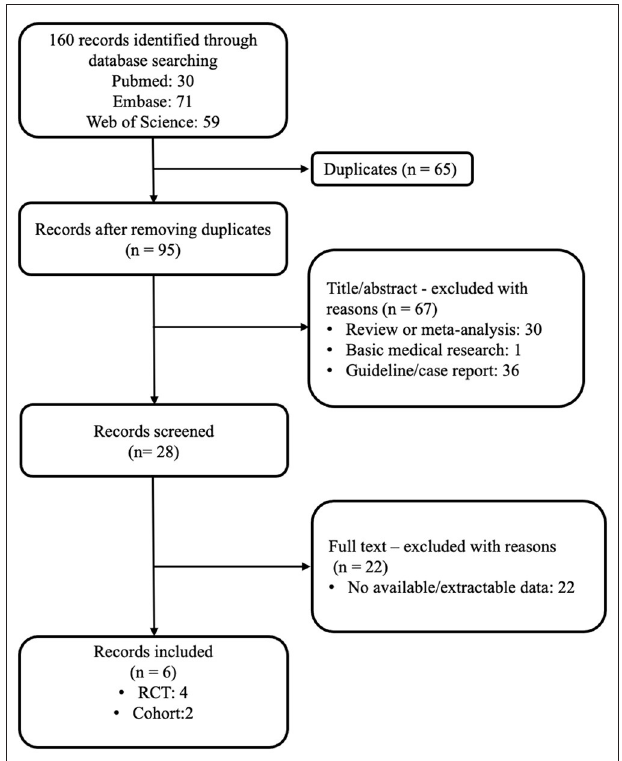
FIGURE 1 | Flow chart of article selection in this